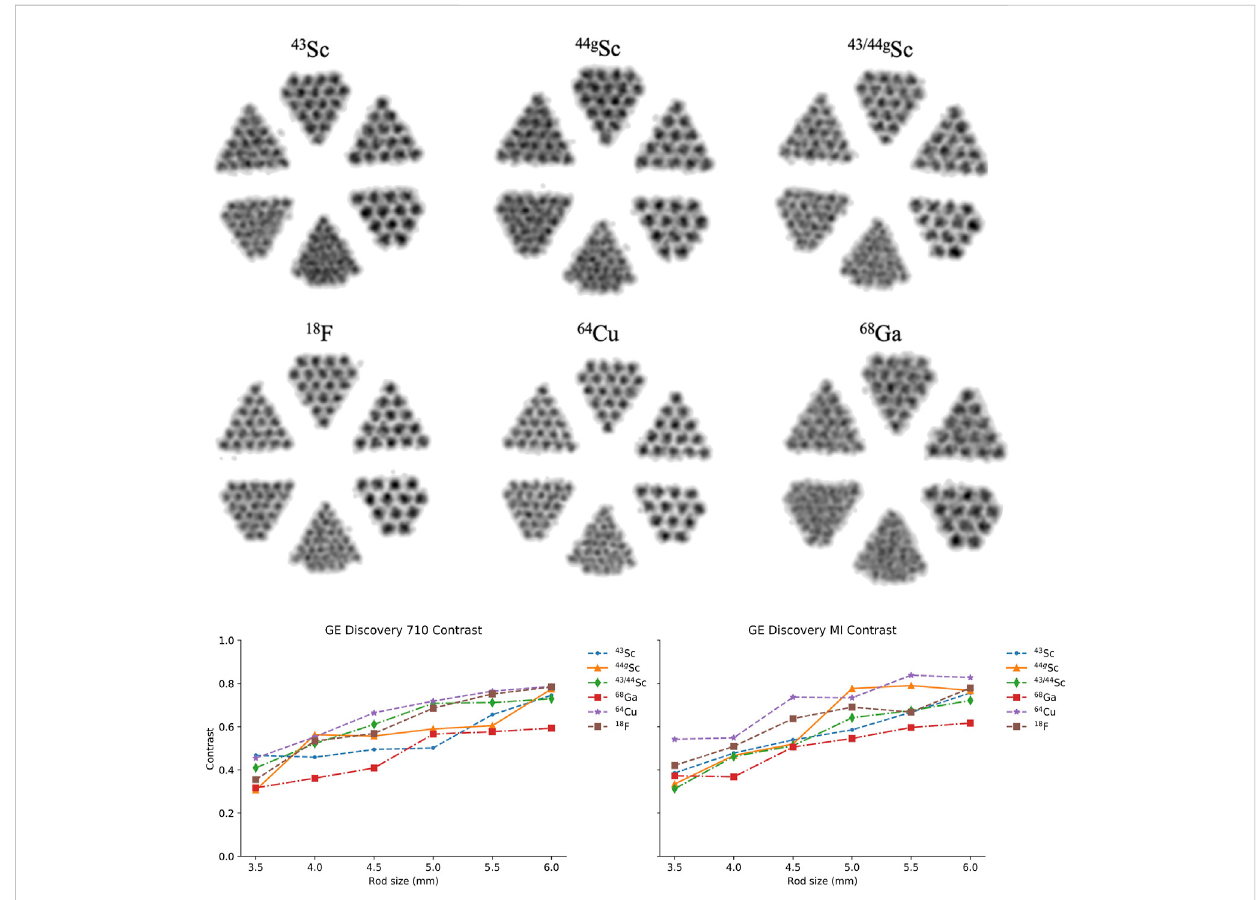
FIGURE 9 Reconstructed PET scans of the Derenzo phantom fi lled with each radionuclide on the GE Discovery 710 (top). Comparison of contrast ( C rod ) for each radionuclide investigated on both scanners